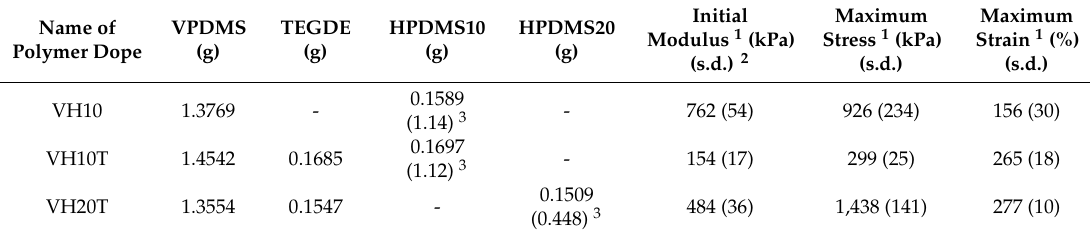
Table 2. Composition of polymer dopes and mechanical properties of the crosslinked PDMS films cured at 80 ◦ C for 2 h